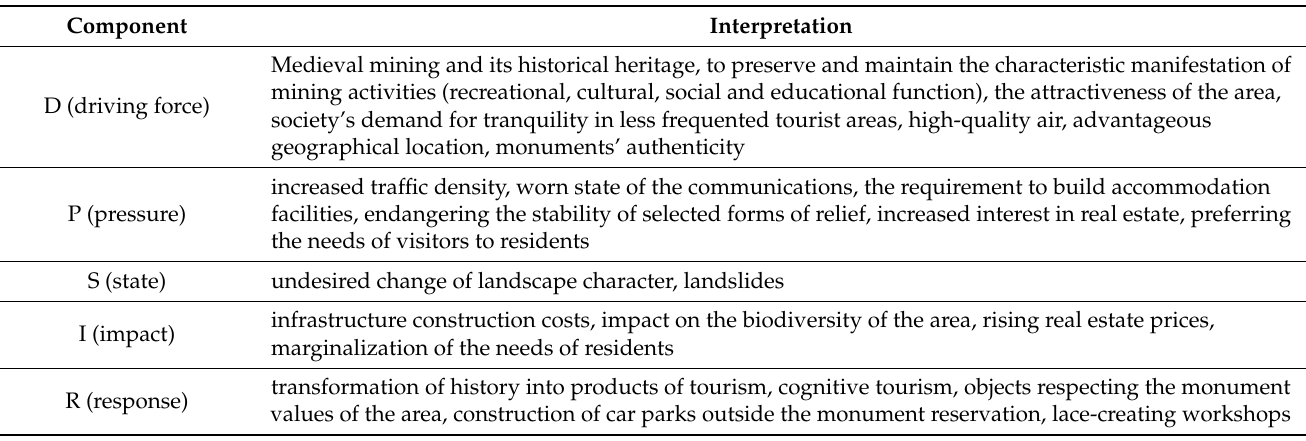
Table 6. DPSIR model for Špania